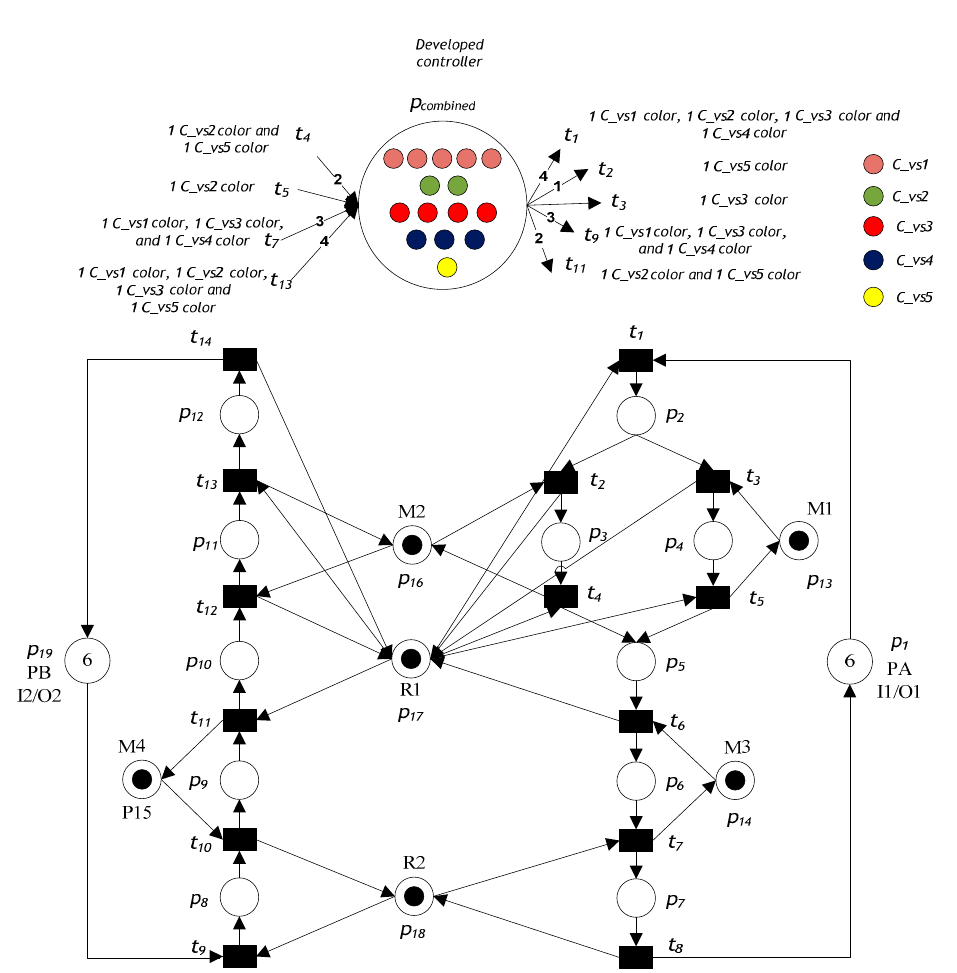
Figure 11. Colored controlled Petri net model of the system. Table 2. Comparison with the existing policies: number of monitors, number of arcs, liveness, and reachable marking.